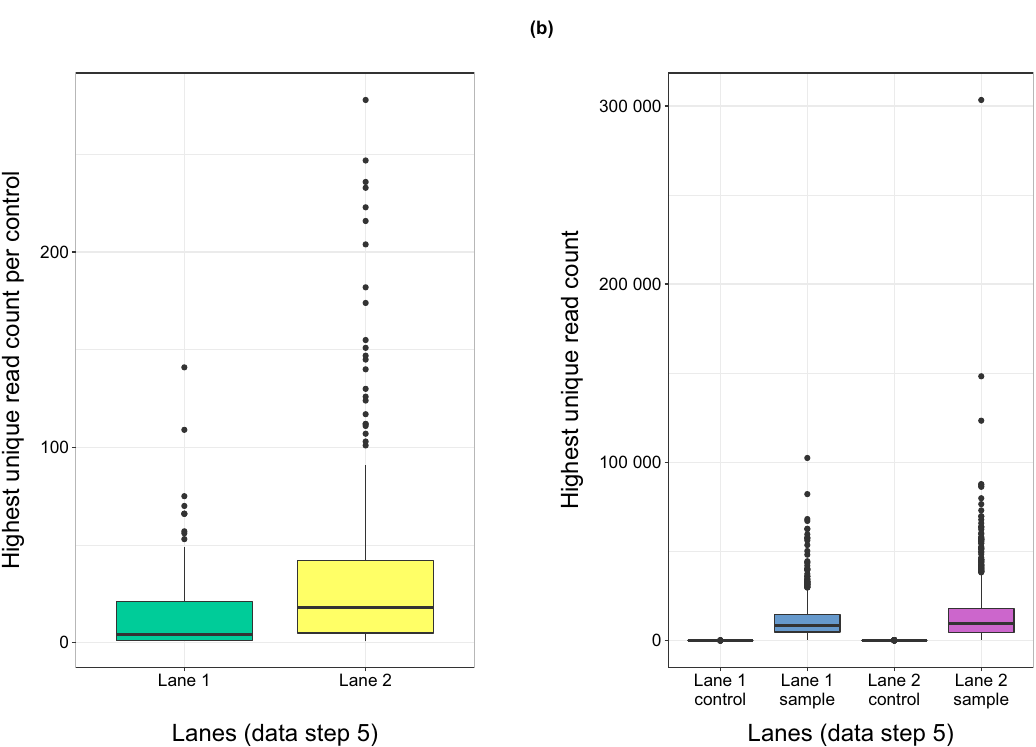
Figure 7. ( a ) Boxplots showing the highest unique read count (read number of highest abundant sequence within one control after reduction filtering step (5)) for each of the control samples (n = 370) of lane 1 and 2. According to the largest data point of 280 read counts for lane 2, this value was used as index hopping threshold. ( b ) Comparison of the highest unique read count between control samples (n = 370) and dietary samples (n = 1920) for both lanes; boxplots of controls are displayed larger in ( a